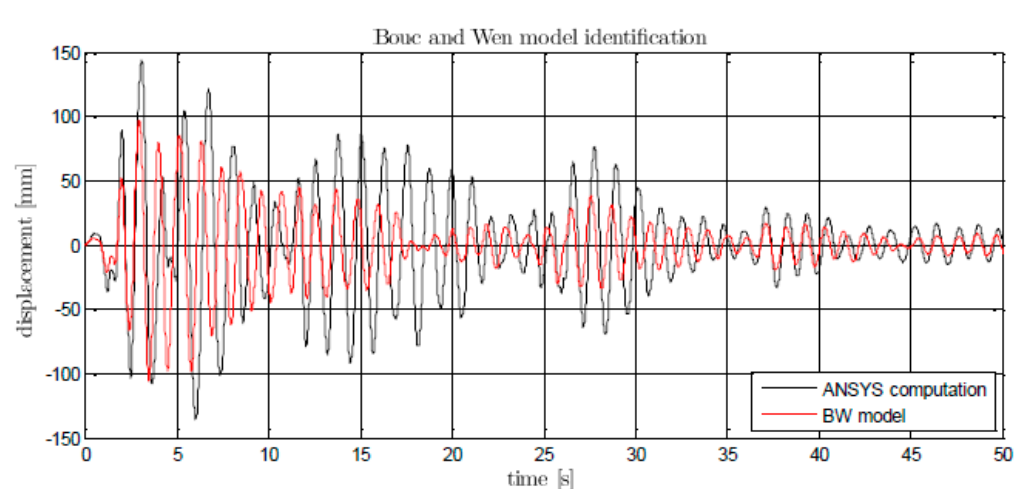
Figure 4: Displacement time history: comparison between BW identified model and ANSYS results (2 nd attempt).